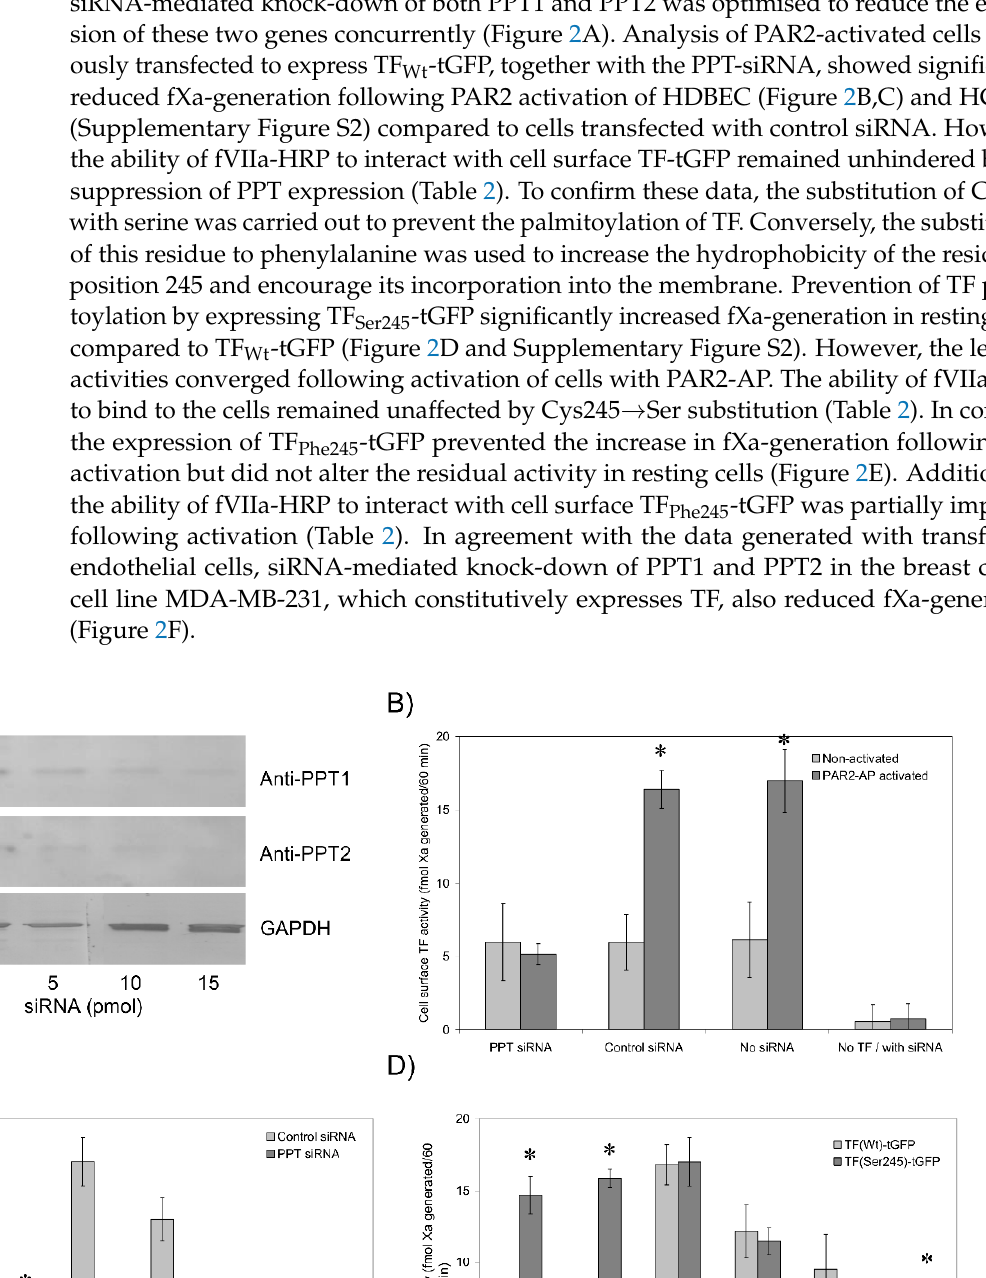
Figure 2. Analysis of TF-tGFP procoagulant activity and fVIIa-HRP binding in the presence and absence of TF pal- mitoylation. ( A ) HDBEC (5 × 10 4 ) were transfected with PPT-siRNA (0–15 pmol) and the expression of PPT1 and -2 meas- ured by western blot. ( B ) HDBEC were co-transfected with combinations of pCMV-Ac-TF-tGFP and PPT-siRNA or control siRNA, and fXa-generation was measured in resting and PAR2-activated cells. ( n = 5, * = p < 0.05 vs. the respective non- activated sample.) ( C ) HDBEC were co-transfected to express TF-tGFP, with PPT siRNA or control siRNA. Factor Xa- generation was measured before and after PAR2 activation for up to 60 min. ( n = 4, * = p < 0.05 vs. the respective control siRNA sample.) HDBEC were transfected to express ( D ) TF Ser245 -tGFP or ( E ) TF Phe245 -tGFP and fXa-generation were meas- ured as above. ( n = 6, * = p < 0.05 vs. the respective cells expressing TF Wt -tGFP.) ( F ) MDA-MB-231 (5 × 10 4 ) cells expressing endogenous TF were transfected with PPT-siRNA or control siRNA and fXa-generation measured ( n = 3, * = p < 0.05 vs. cells without siRNA). 3.4. De-Palmitoylation of Cys245 Promotes the Aggregation of TF on the Cell Membrane It has been reported that the procoagulant activity of TF is strongly influenced by the membrane microenvironment [21–23]. We hypothesised that de-palmitoylation of TF fol- lowing cellular activation may sequester TF molecules into specific microdomains within the cell membrane. Therefore, the aggregation of TF-tGFP variants before and after cellu- lar activation was examined by confocal microscopy. These were compared to cells ex- pressing TF Wt -tGFP in which the expression of PPT1 and PPT2 was silenced. Examination